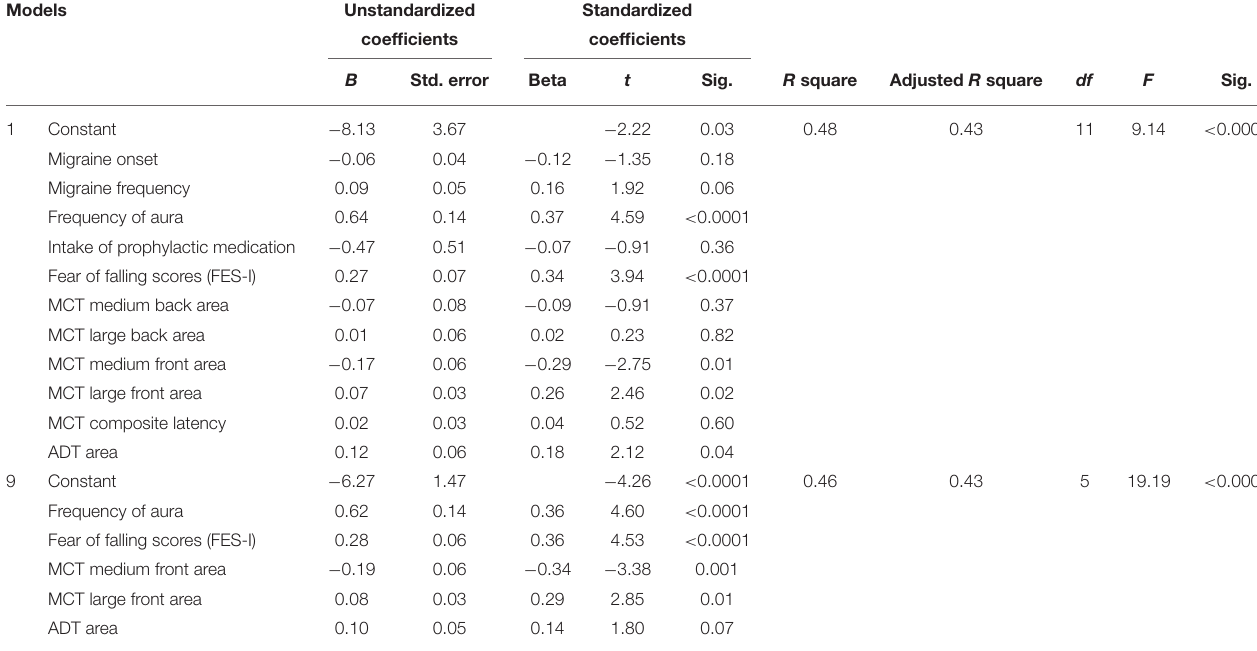
TABLE 3 | Multiple linear regression for prediction of the number of falls based on clinical and motor reaction variables.